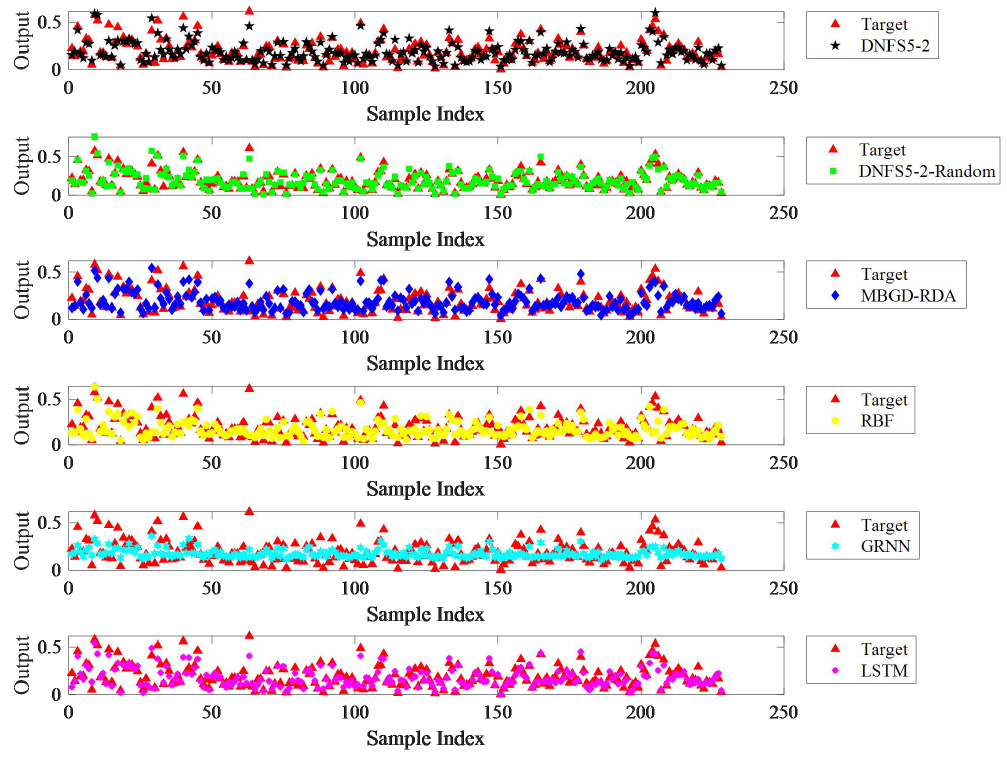
Figure 7. Prediction charts of different algorithms on Test Dataset No. 2.